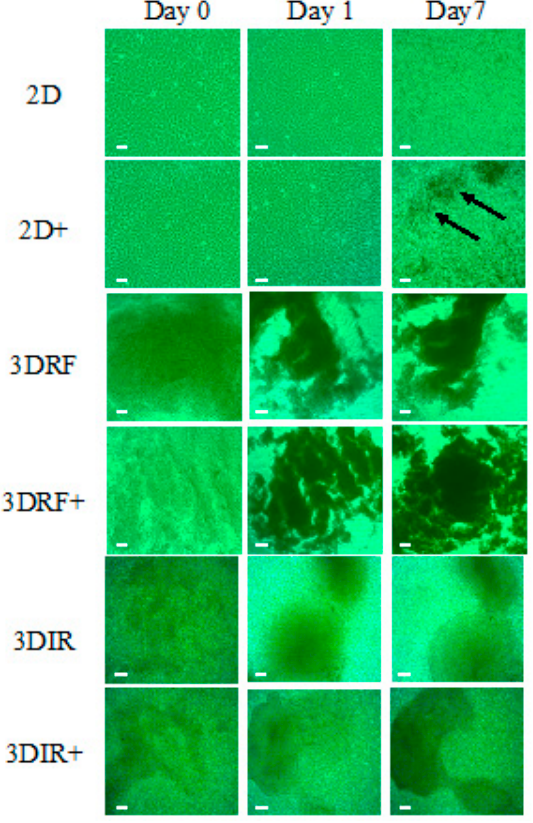
Figure 5. Cell morphology observations. 2D: KUSA-A1 cells were cultured without osteogenic differentiation medium on a plastic plate. 2D+: KUSA-A1 cells were cultured with osteogenic differentiation medium on a plastic plate. Discrete mineralized nodules are indicated by arrows. 3DRF: KUSA-A1 cells were encapsulated in GelMA–RF hydrogel without osteogenic differentiation medium. 3DRF+: KUSA-A1 cells were encapsulated in GelMA–RF hydrogel with osteogenic differentiation medium. 3DIR: KUSA-A1 cells were encapsulated in GelMA–IR hydrogel without osteogenic differentiation medium. 3DIR+: KUSA-A1 cells were encapsulated in GelMA–IR hydrogel with osteogenic differentiation medium. KUSA-A1 cells aggregated and exhibited spheroid-like formations in the GelMA-RF and GelMA–IR hydrogel cultures. Scale bars: 100 µ